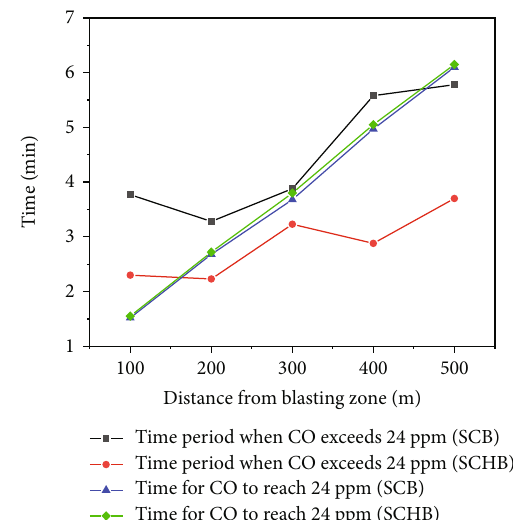
Figure 20: Time taken by CO to reach 24ppm and exceed the same with monitoring distance in four-hole SCB and